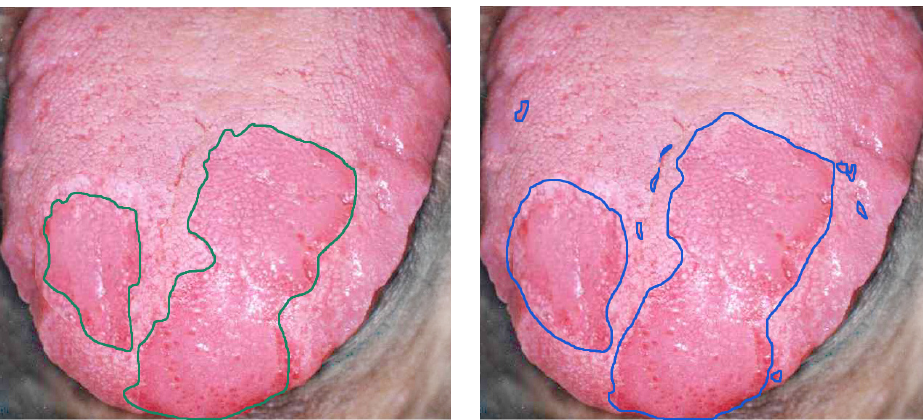
Figure 7. Tumor region. Expert labeling ( left ) and classifier prediction of tumor regions ( right ).